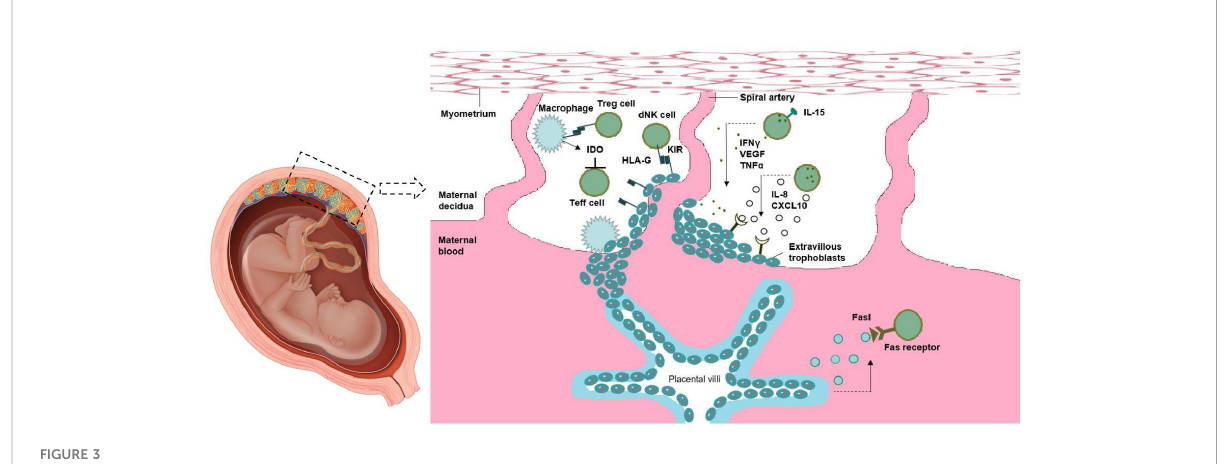
FIGURE 3 Maternal-fetal immune